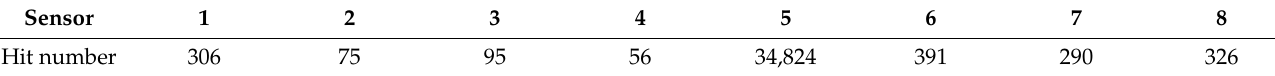
Table 5. The hit number of each channel.